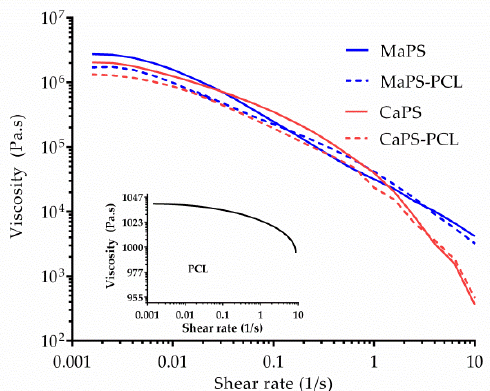
Figure 5. Viscosity of the starch composites as a function of shear rate at 130 ◦ C. Inset: viscosity of polycaprolactone under the same conditions.